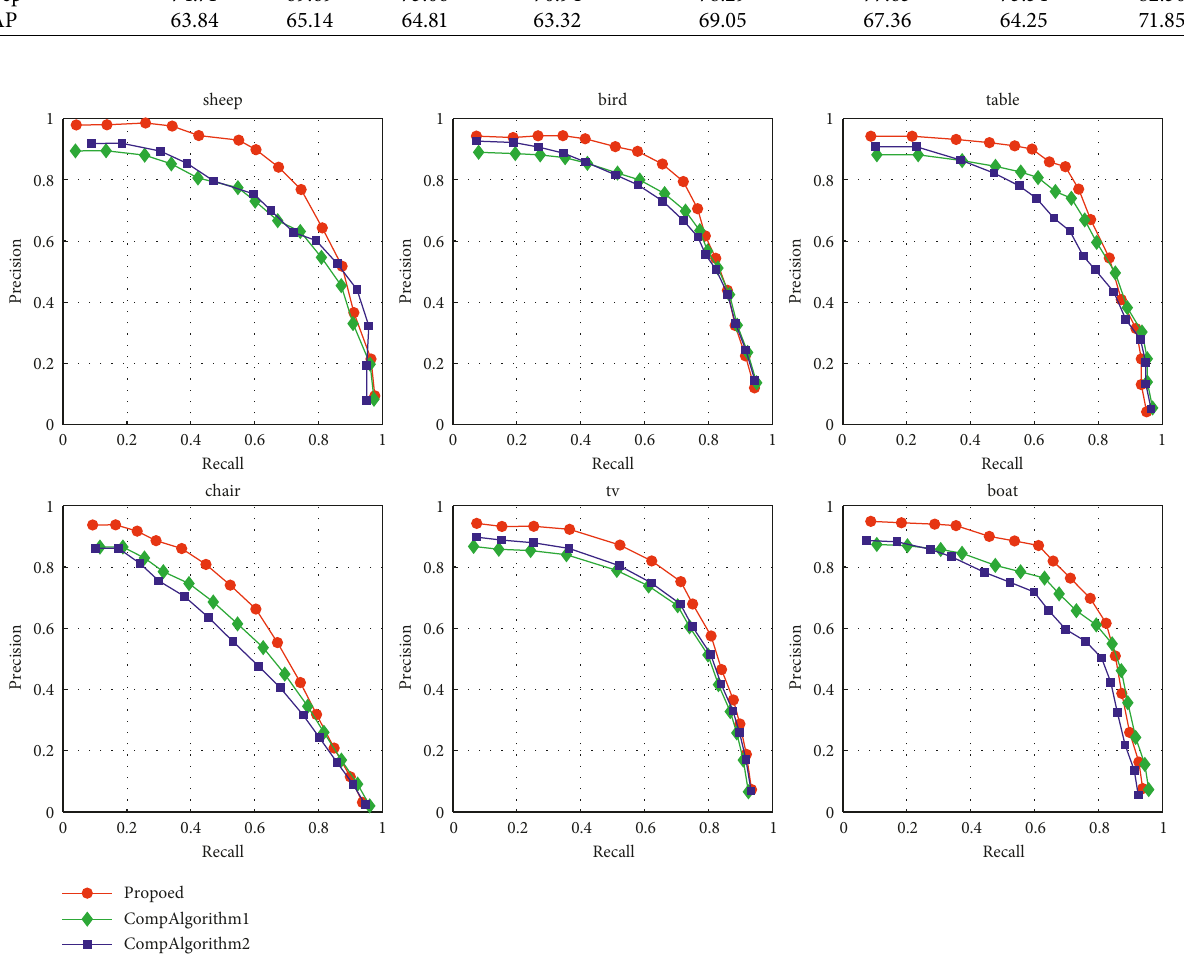
Figure 8: P-R curve on the VOC2007